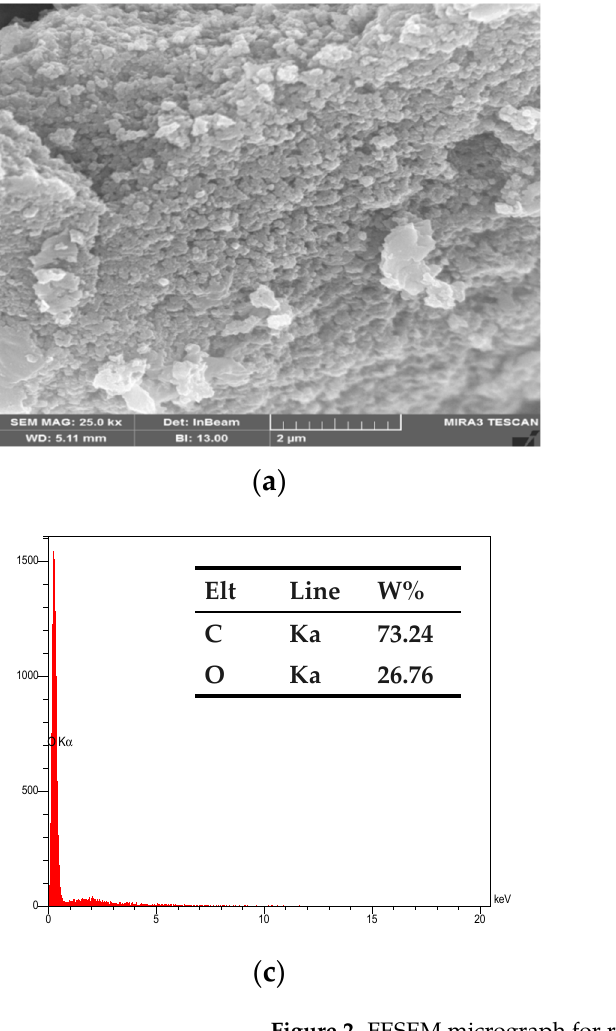
Figure 2. FESEM micrograph for raw nano AC ( a ) and modified AC-SML ( b ). EDX spectrum and elemental composition for raw AC ( c ) and AC-SML nanocomposite ( d ).